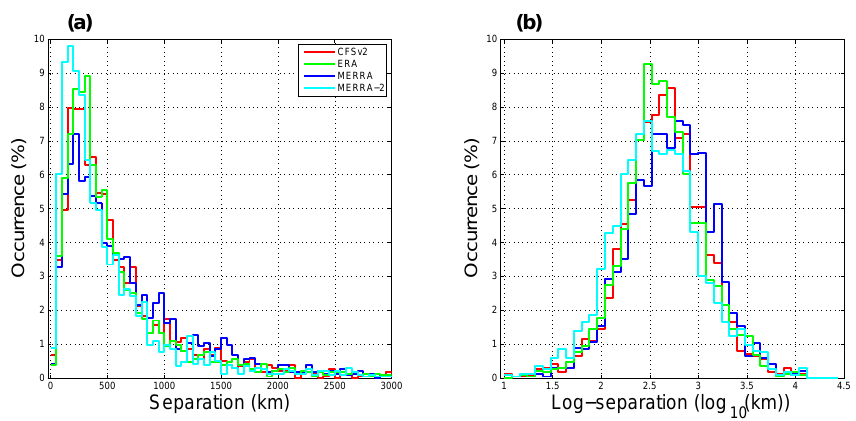
Figure 6. Histogram of the trajectory separation distribution after 5 days. (b) is the same as (a) , but using logarithmic separation to highlight the log-normal distribution, with a long tail of extreme outliers which is not visible in (a)